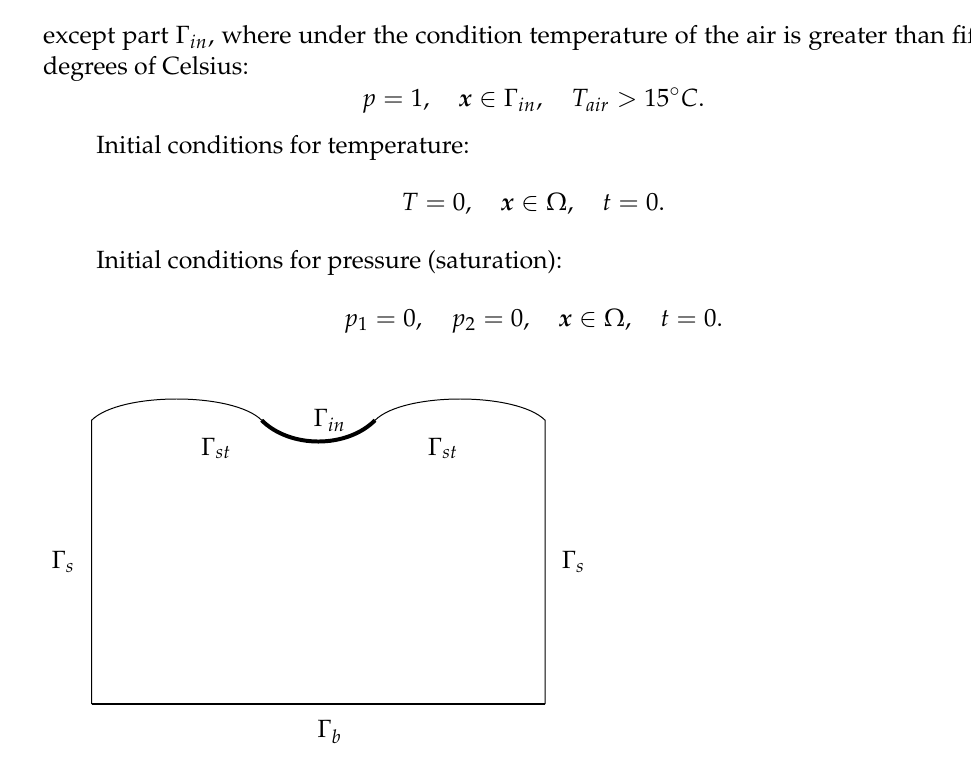
Figure 1. Domain Ω with boundaries Γ in , Γ st , Γ s , Γ b